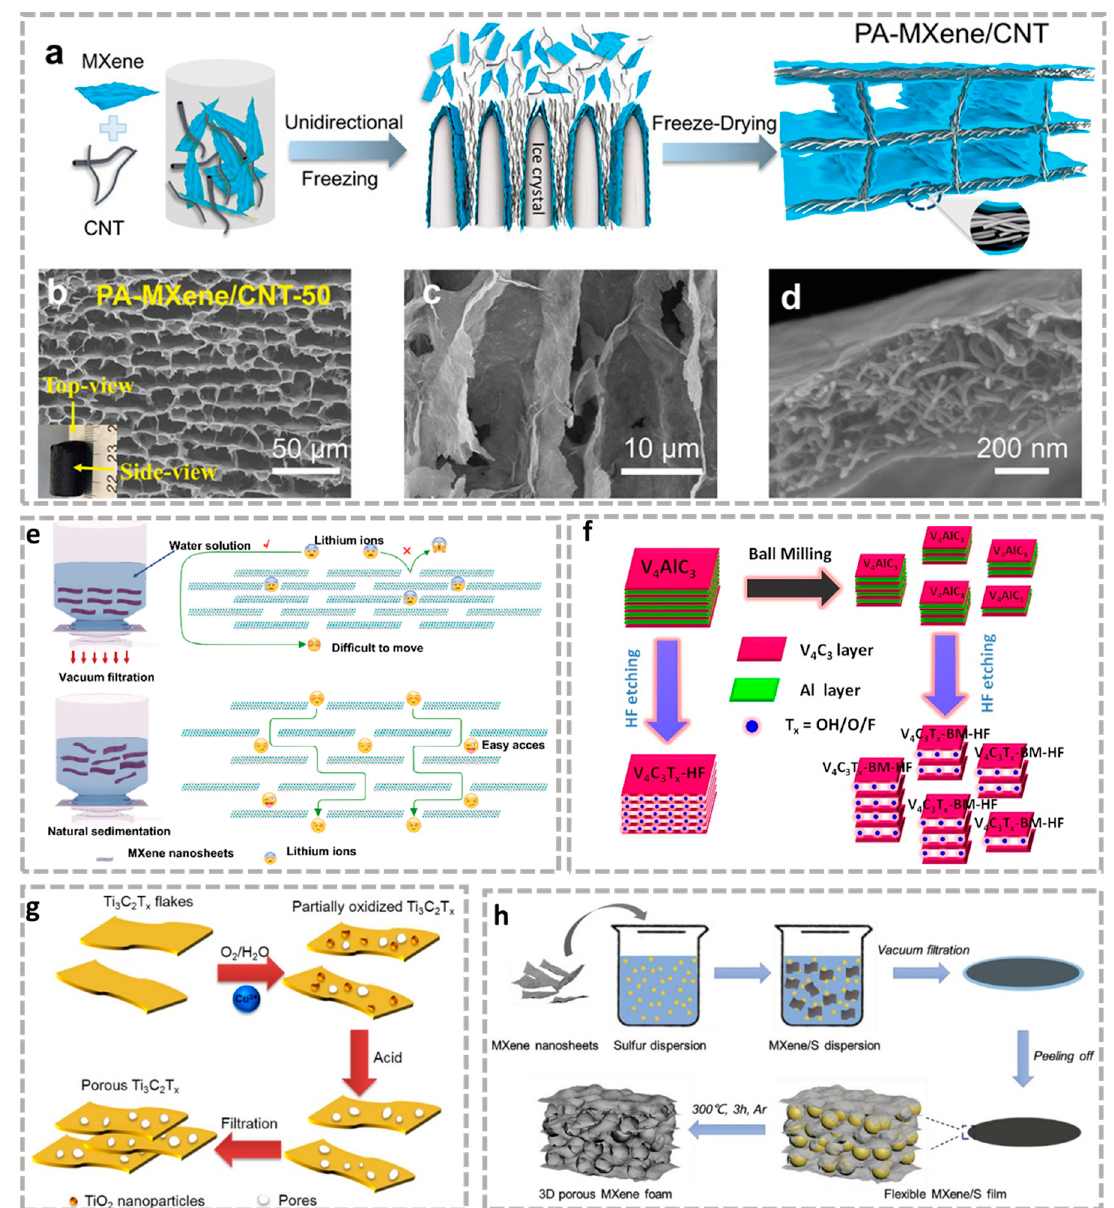
Figure 4. ( a ) PA-MXene/CNT preparation scheme using unidirectional freeze-drying; ( b – d ) SEM image of PA-MXene/CNT [61]. ( a – d ) Reproduced with permission from WILEY-VCH. ( e ) Compar- ison of MXene fi lms naturally sedimented and conventional fi ltered under vacuum [57]. ( e ) Repro- duced with permission from Springer Nature. ( f ) Schematic showing the two di ff erent processes of V 4 C 3 T x MXene [58]. ( f ) Reproduced with permission from ELSEVIER BV. ( g ) Diagram showing the chemical engraving of Ti 3 C 2 T x fl akes to produce a porous structure [60]. ( g ) Reproduced with per- mission from John Wiley and Sons. ( h ) Diagram of the porous, free-standing, and fl exible 3D MXene foam prepared with an S template [59]. ( h ) Reproduced with permission from WILEY VCH.